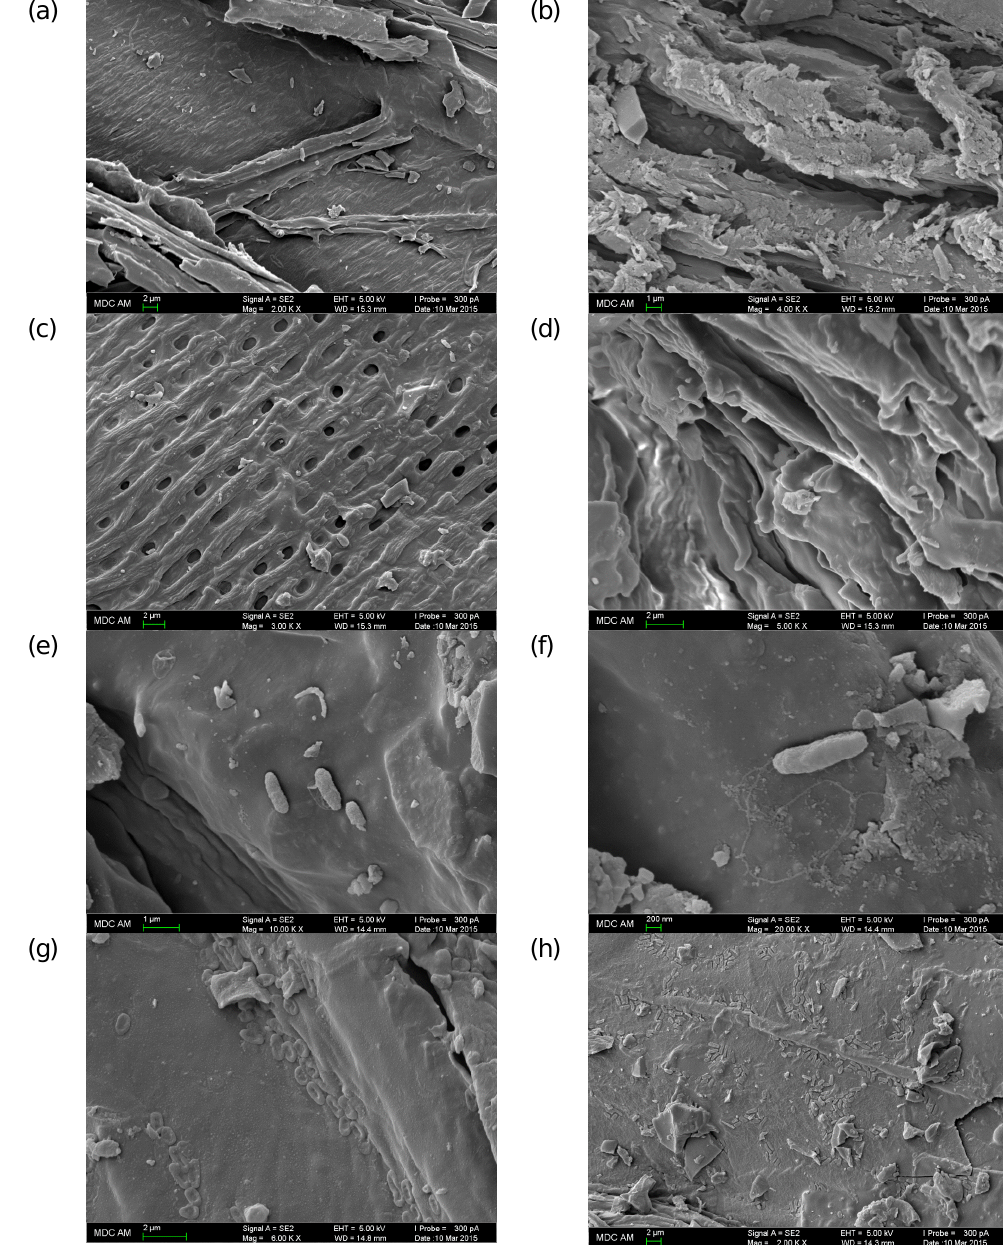
Figure 1. Scanning electron microscope images of initial biochar (a–d) , biochar with immobilized cells of P. aeruginosa (e, f) , and biochar with immobilized cells of A. radioresistens (g, h)